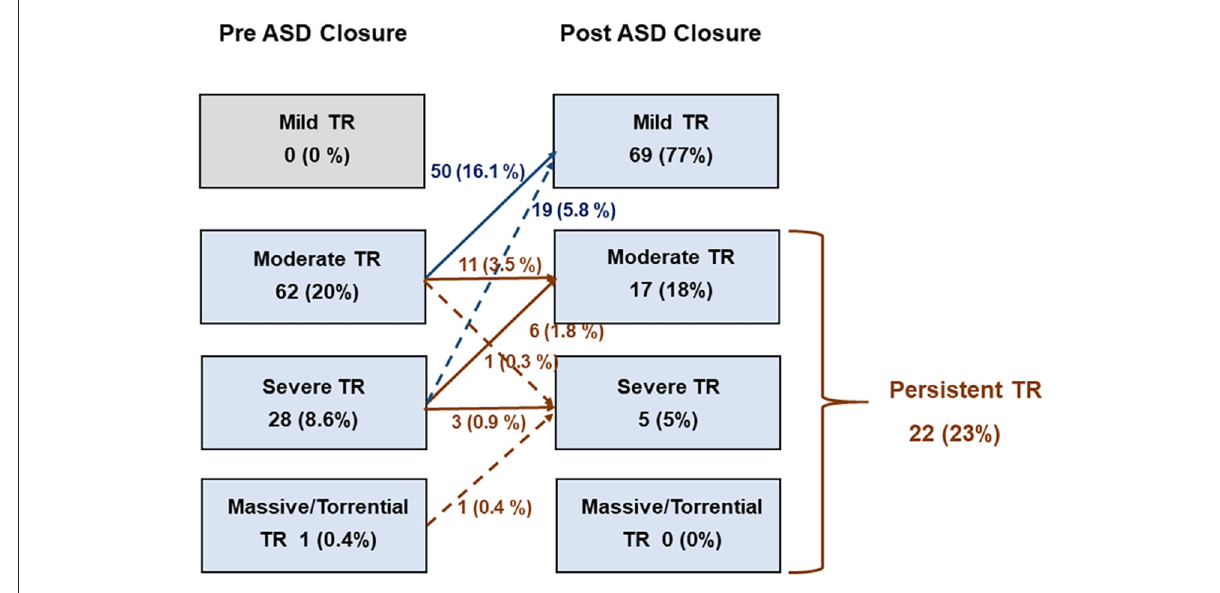
FIGURE2 Changes in tricuspid regurgitation after closure of atrial septal